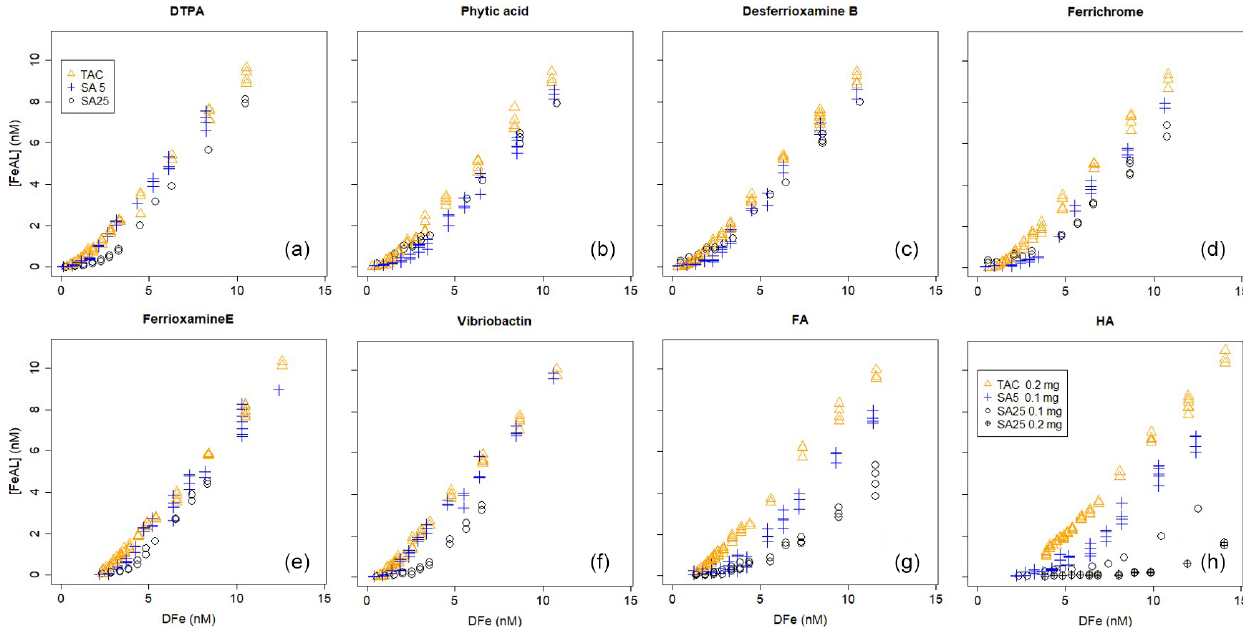
Figure 1. Iron titrations of UV-irradiated seawater containing model ligands in competition with TAC, SA5 and SA25 as added ligand. (FeAL) is Fe-added ligand complex using sensitivity ( S) = 1 and (Fe) is total iron concentration. See Table 2 for the DFe at zero addition. (a) DTPA, (b) phytic acid, (c) desferrioxamine B , (d) ferrichrome, (e) ferrioxamine E (saturated with Fe), (f) vibriobactin, (g) fulvic acid FA and (h) humic acid HA. Data for TAC and SA5 are from duplicate experiments, and data for SA25 are from single experiments, except for FA and HA where for SA25 duplicate experiments were also done. Note the different HA concentrations, 0.1 and